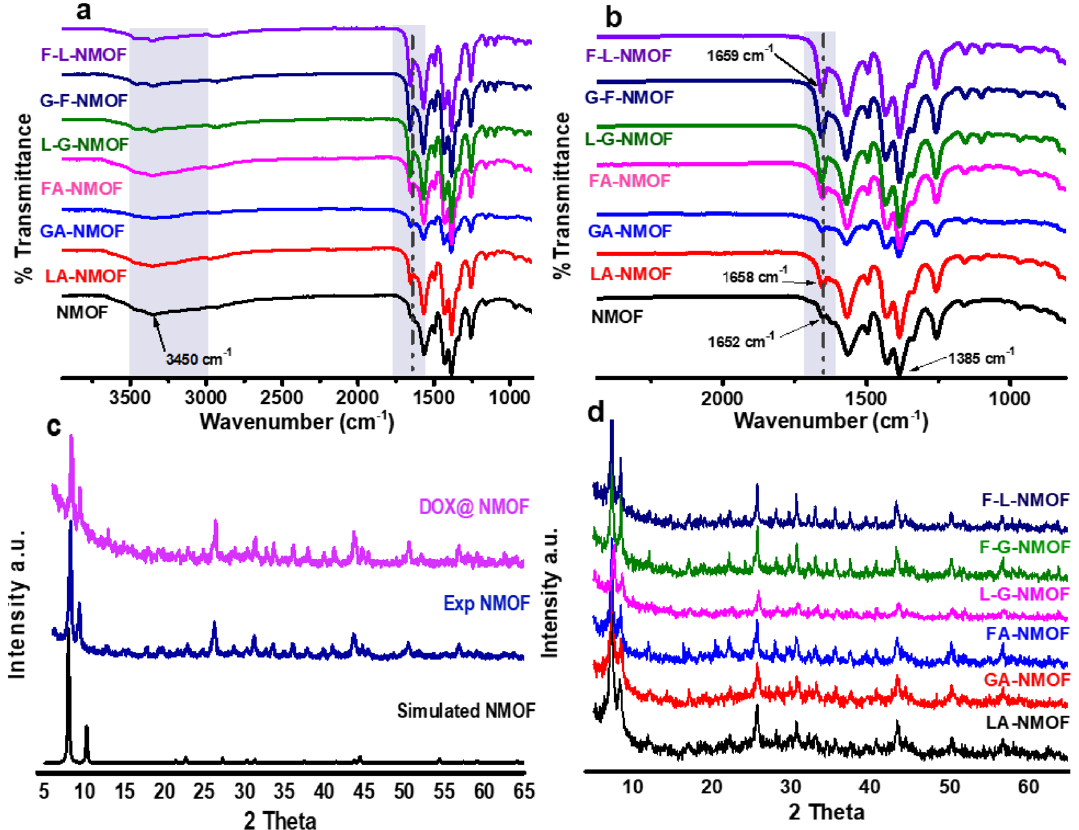
Figure 2. ( a , b ) FTIR spectra of NMOF, FA-NMOF, LA-NMOF, GA-NMOF, FA-LA-NMOF, GA-FA-NMOF and LA-GA-NMOF ( c ) PXRD for simulated NMOF, exp NMOF and DOX-loaded NMOF, and ( d ) PXRD for mono- and dual-ligated